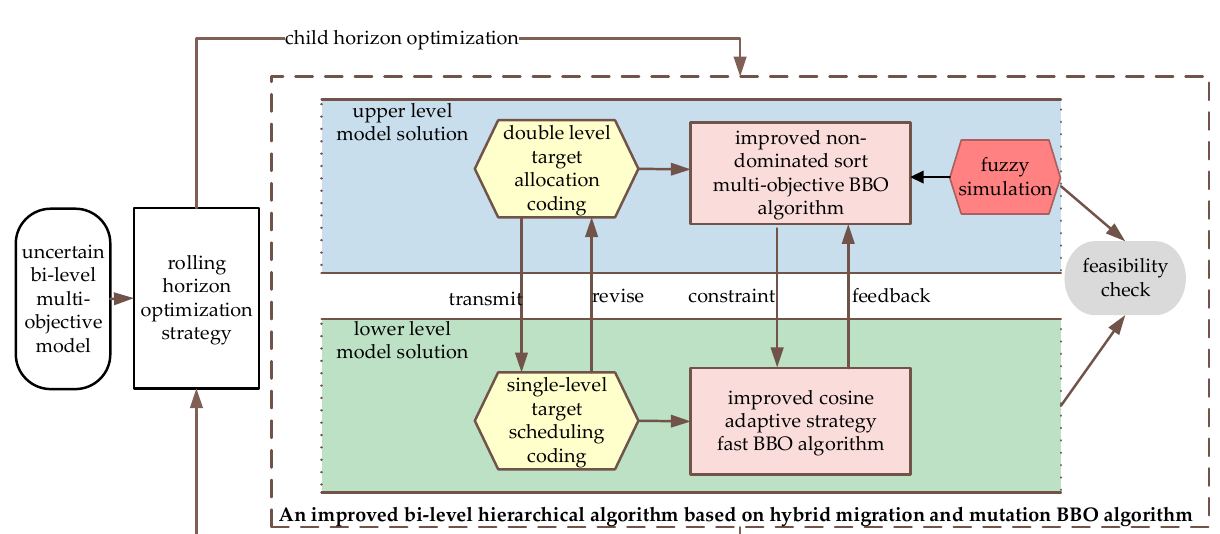
Figure 10. Equations 15 and 16 experimental results.